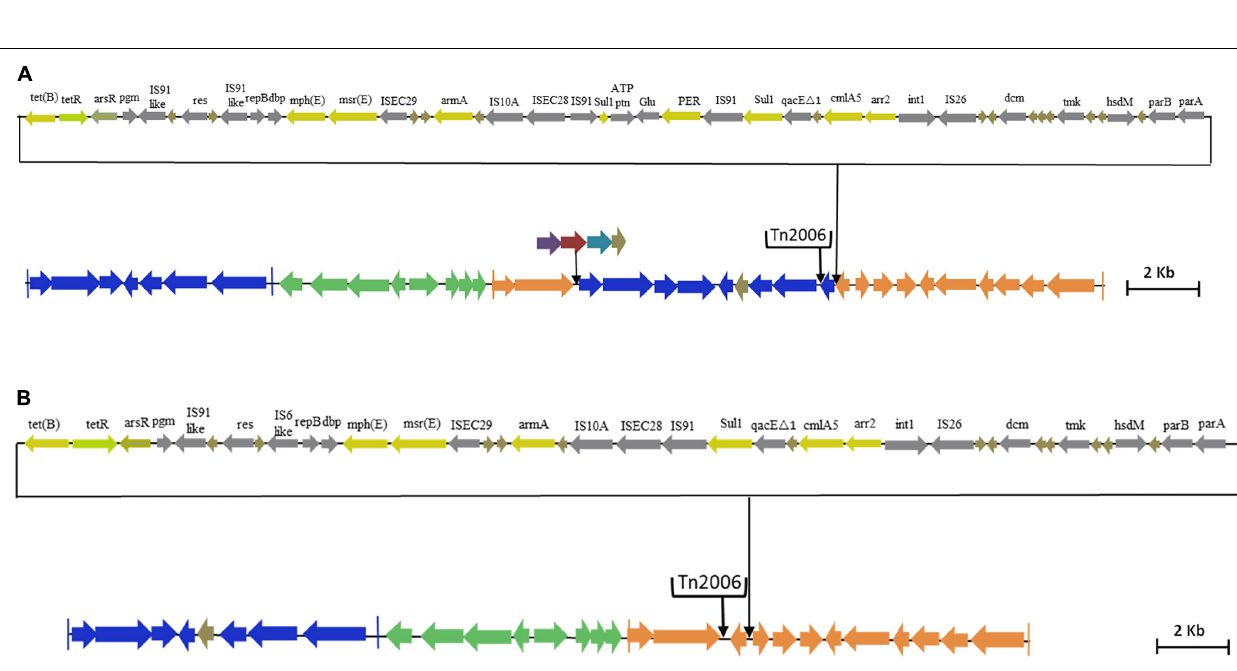
Frontiers in Microbiology |